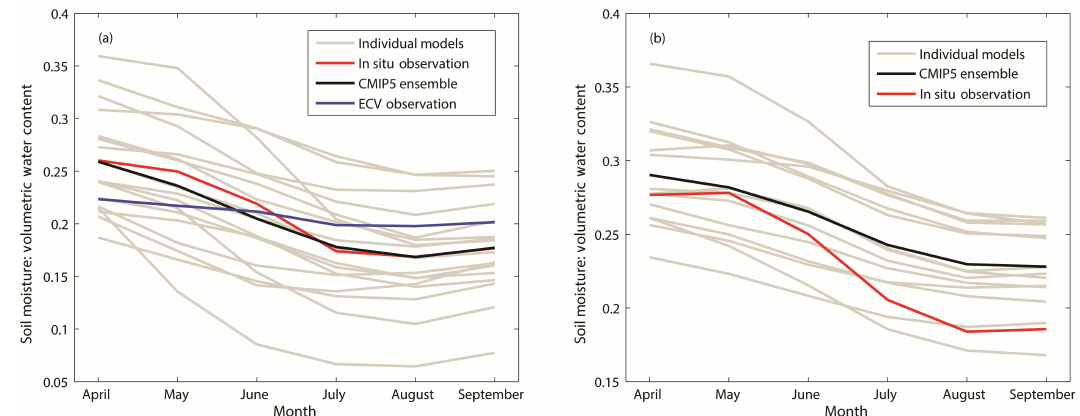
Figure 3. Mean monthly soil moisture (2003–2012) during the warm season (April to September) in the 0–10cm soil layer (a) and in the 0–100cm soil layer (b) . Data are spatially averaged over CONUS. Figures show the monthly mean soil moisture from the in situ observations (red line), ECV satellite data (blue line), CMIP5 ensemble mean (black line) and the individual CMIP5 models (grey